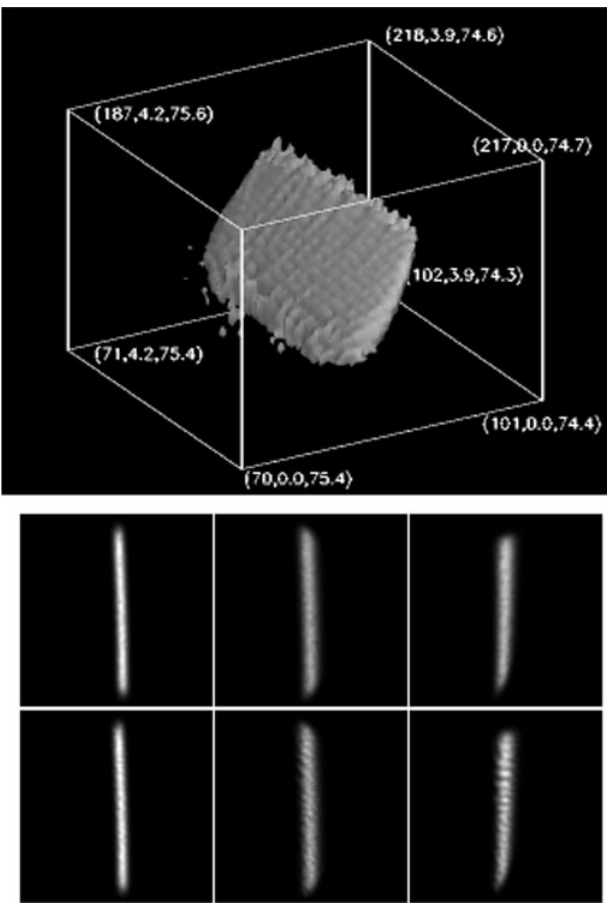
Fig. 2. Model of an auroral arc within a 61 (cid:2) 61 (cid:2) 61 voxel volume. Each cube mark represents altitude, geocentric magnetic longitude, and geocentric magnetic latitude. The images correspond to images taken by cameras from three locations according to the observation geometry used in Norway, 1995 (lower images) and the images of the MART reconstructed arc are shown at the top